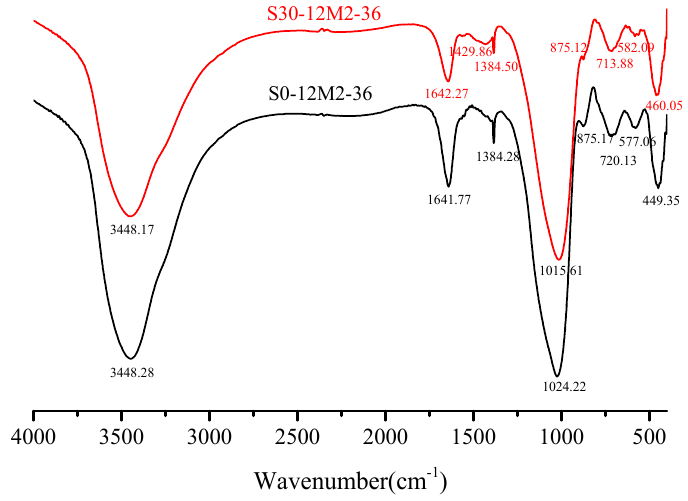
Figure 7. FTIR characterization of hardened paste with different slag contents.